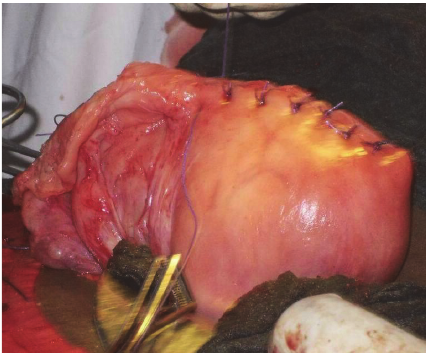
Figure 3: Uterus after placenta removal and uterine